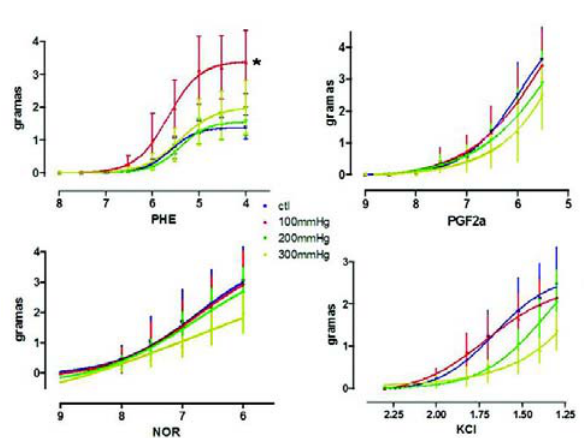
Fig. 5 - Curva dose-resposta a concentrações crescentes de fenilefrina, prostaglandina F2á, noradrenalina e cloreto de potássio (n=6, ANOVA, p<0,05 apenas para contrações de veias safenas distendidas a 100 mmHg, para os demais parâmetros p>0,05). O